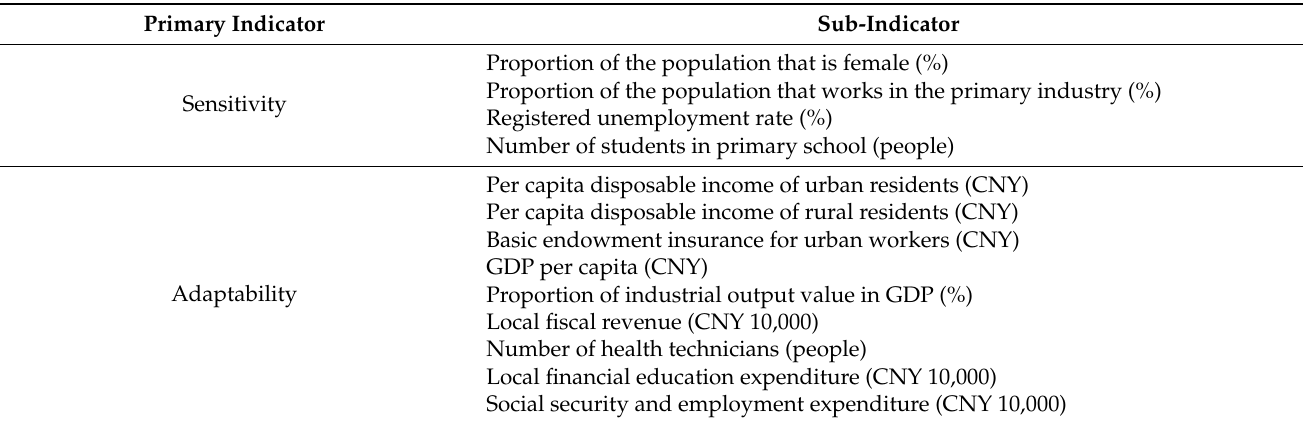
Table 2. Indicators used for the social vulnerability index calculation. Primary Indicator Sub-Indicator Proportion of the population that is female (%) Proportion of the population that works in the primary industry (%) Sensitivity Registered unemployment rate